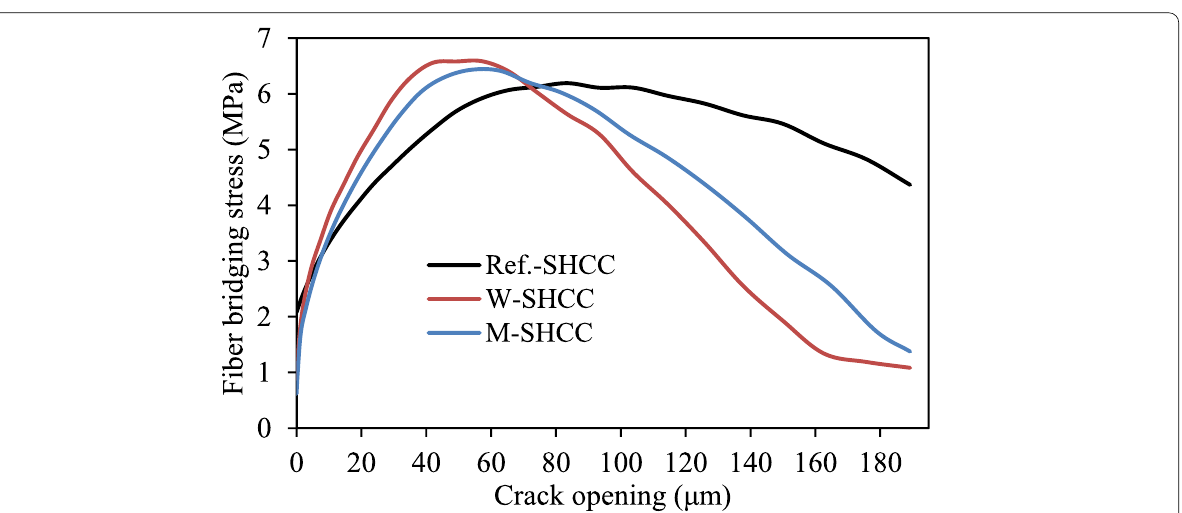
Fig. 10 Theoretical relationships between fiber bridging stress and crack